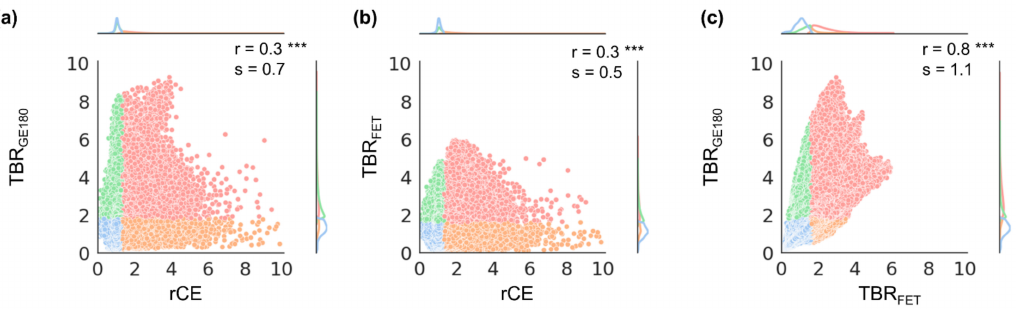
Figure 2. Voxel-wise correlation plots for voxel values from all patients comparing tumor-to- background ratios (TBR) and relative contrast enhancement (rCE): ( a ) TBR GE180 vs. rCE, ( b ) TBR FET vs. rCE, and ( c ) TBR GE180 vs. TBR FET . Color coding of data points illustrates whether the voxel values belong to TBR or rCE positive or negative analysis volumes: Red: Voxels are contained in both analysis volumes, Blue: Voxels are outside both analysis volumes, Orange or green: Voxels are within one analysis volume only. Significances obtained from Pearson’s correlation and the corresponding correlation coefficients (r) and slopes (s) are provided in the upper right corner. Significance was grouped as strong ( p < 0.001, denoted with ***).